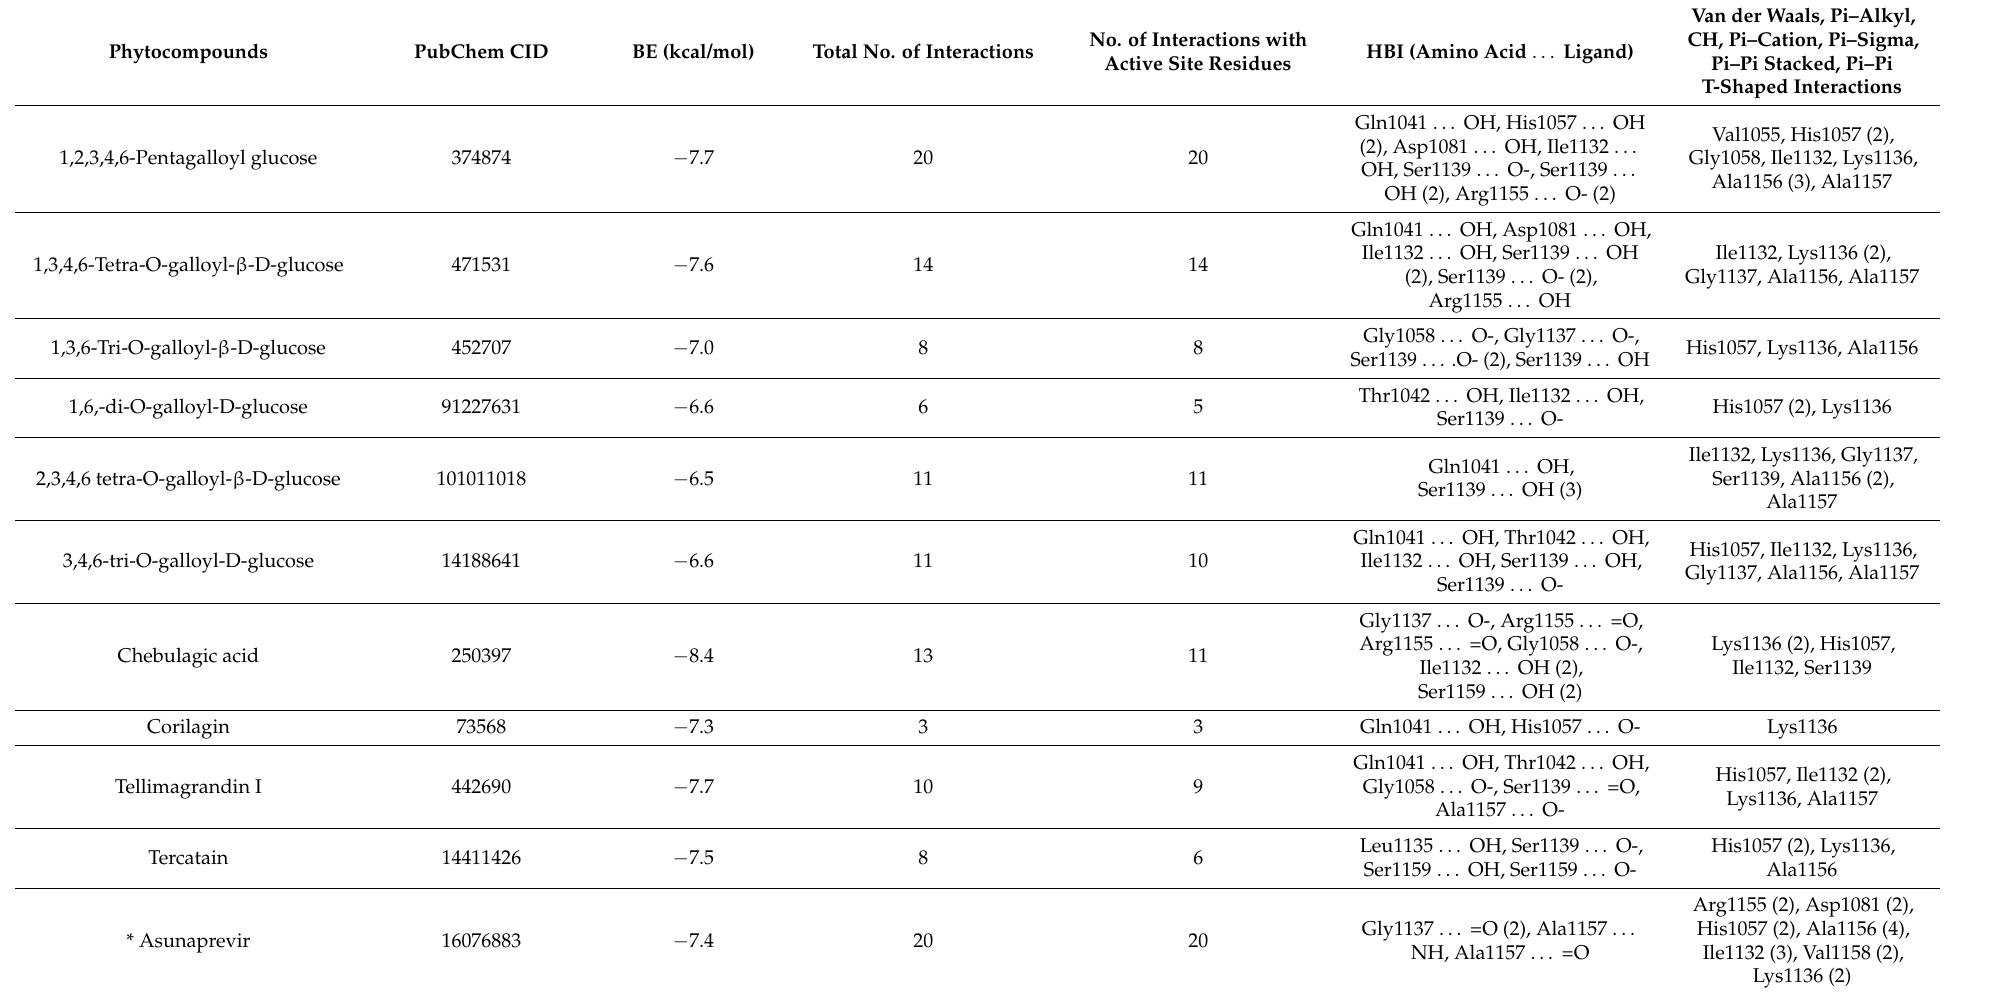
Table 3. Binding affinity of prioritized phytocompounds with HCV